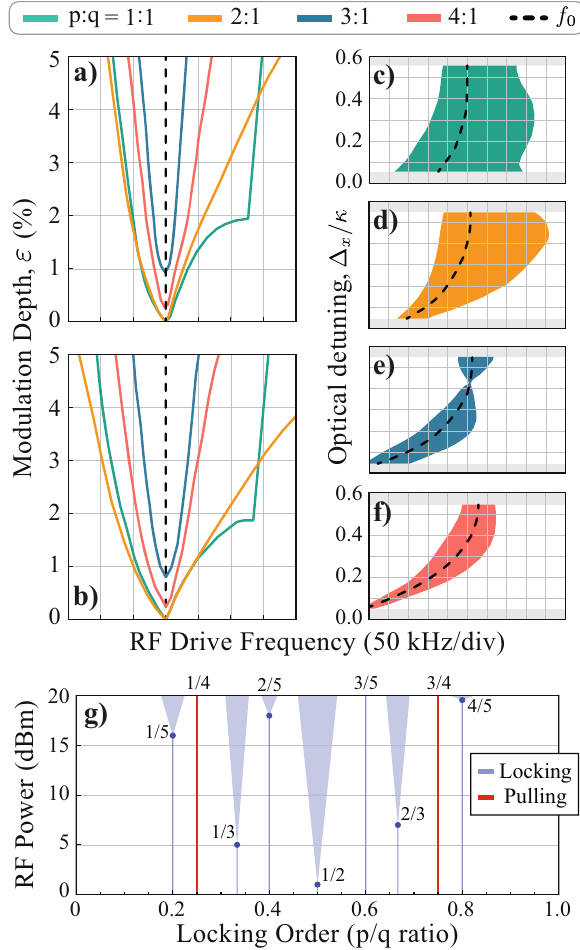
is also remarkable that the p = 3 synchronization window is relatively small, counterposing the hierarchy among harmonics. Fig. 3 Numerical analysis and experimental observation of fractional synchronization. a Arnold tongues boundaries simulated using the complete coupled optomechanical equations. The horizontal scale is the same used in experimental data of Fig. 2l – o, revealing a good agreement; b Same simulation done at ( a ) but now considering only one parametric term in each simulation, i.e., the green (1:1) boundary was simulated considering ε F 1 = ε F 2 = ε F 3 = 0 but ε F 0 ≠ 0 (details in the Supplementary Note 5). The orange (2:1) boundary has only the term ε F 1 ≠ 0, the blue (3:1) has ε F 2 ≠ 0 and the red (4:1) has ε F 3 ≠ 0; c – f Impact of optical detuning Δ x in the ATs, showing their tunability and the possibility of a vanishing p = 3 tongue at Δ x ≈ 0.43 κ for the parameters used. These maps were simulated using ε = 5% and the black-dashed line is the mechanical oscillation frequency f 0 , which increases with Δ x because of the optical spring effect; g Measured fractional synchronization threshold, indicated as blue dots, to observe a fi nite-width AT. The red lines indicate the locking orders that did not synchronize and only frequency pulling was observed. The Arnold tongues shown are illustrations (see Supplementary Note 2 for actual